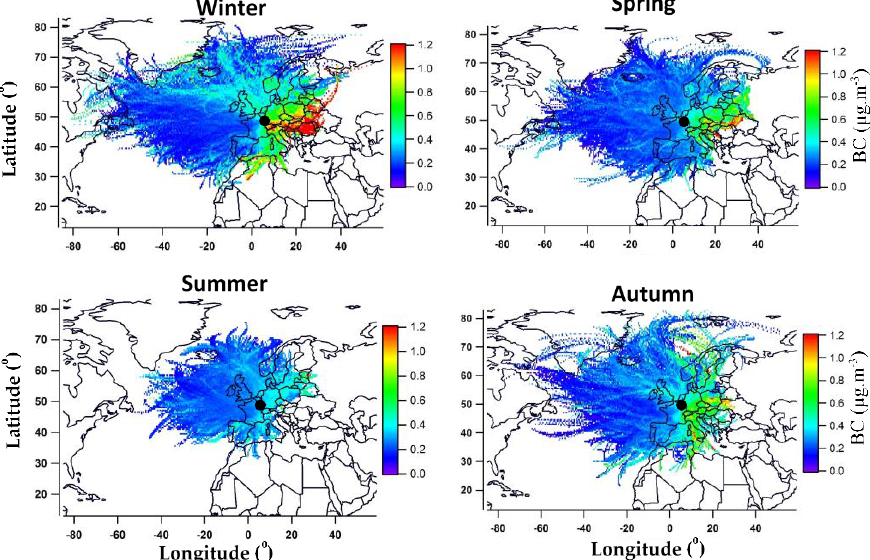
Figure 4. Potential Source Contribution Function (PSCF) results for EBC concentrations for the four seasons over the 2012–2018 period measured at the OPE station (black dot).